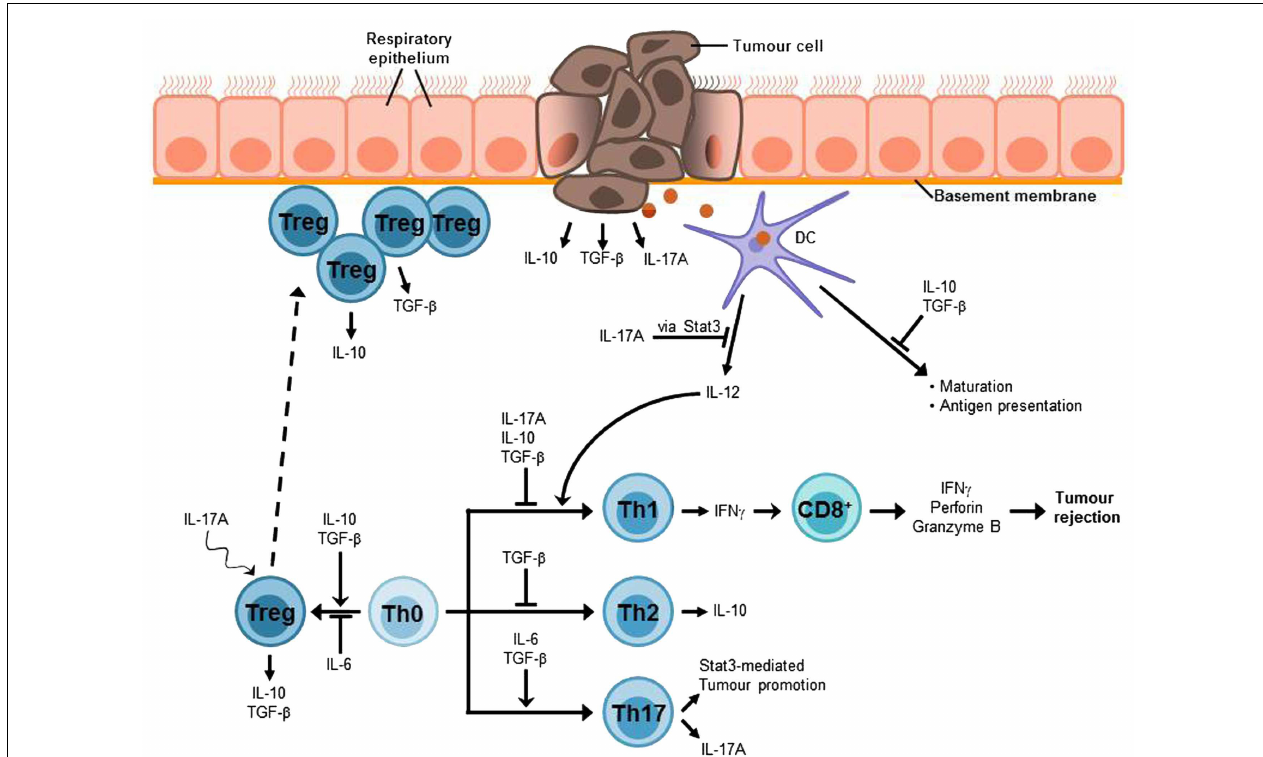
as well as antigen presentation. Moreover, it is involved in the development and function of inducedTreg cells.The immunosuppressive functions of IL-10 include the inhibition ofTh1 cell proliferation and cytokine production as well as the suppression of antigen presentation. In addition, IL-10 is involved inTreg development and function, in particularTr1 cells.The tumor-promoting role of theTh17 cytokine IL-17A can be attributed to its relation to the proto-oncogene Stat3. One function of Stat3 is the inhibition of IL-12 expression which is required for the induction ofTh1 differentiation and thus anti-tumor immune responses.The differentiation ofTh17 cells requires the presence of IL-6 andTGF- β , whereasTreg development is induced byTGF- β alone and IL-6 promotesTreg inhibition. Nevertheless, IL-17A seems to be linked toTreg development in tumor via a mechanism that is still